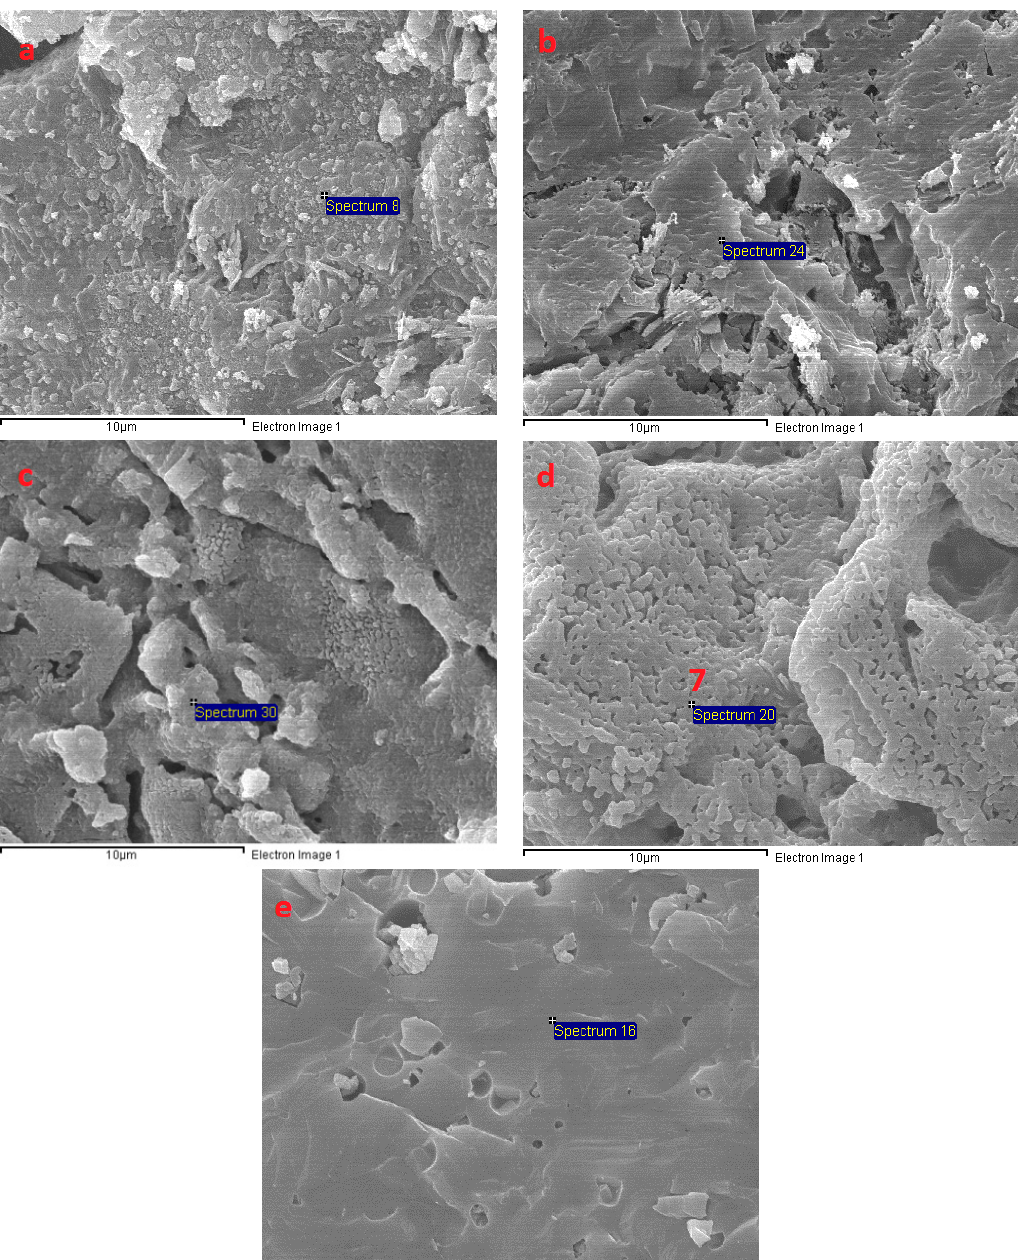
Figure 15. SEM micrographs of fracture surface of A10 at different temperatures: ( a ) 200 ° C ; ( b ) 600 ° C ; ( c ) 800 ° C ; ( d ) 1000 ° C ; and, ( e ) 1200 ° C .